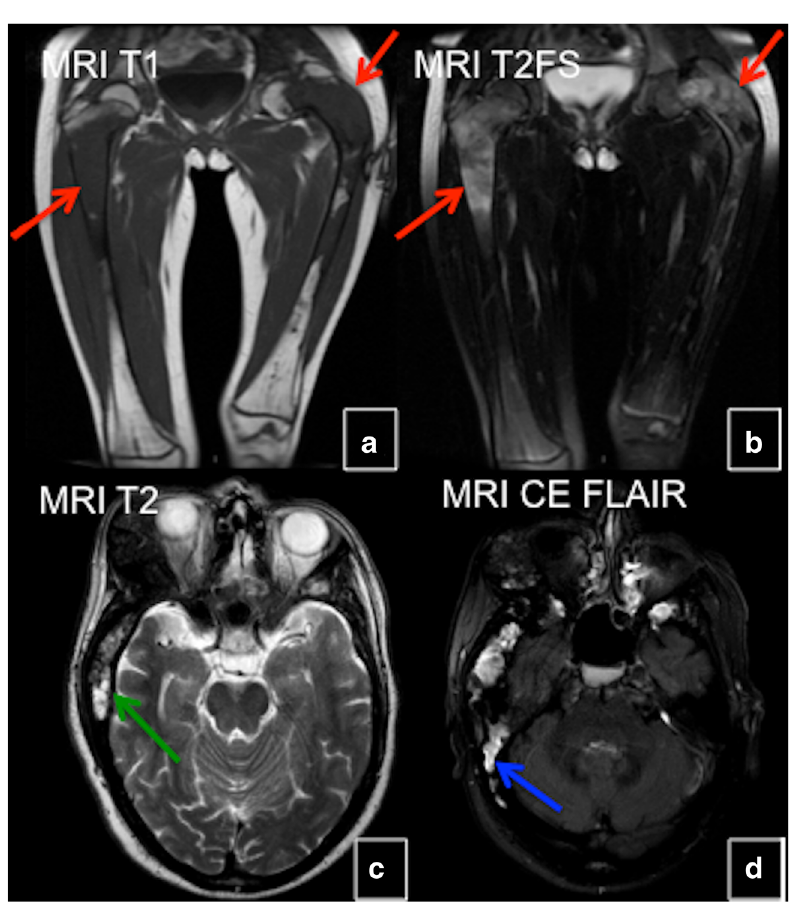
Fig. 7 MRI in fibrous dysplasia (FD). a , b MRI typically shows sharply demarcated lesions with intermediate to low signal intensity on T1-weighted images (WI) and intermediate to high on T2-WI ( red arrow ). c Some FD lesions may also contain small cystic areas, which make the T2 signal bright ( green arrow ). d FD lesions usually show some degree of enhancement after contrast administration ( blue arrow